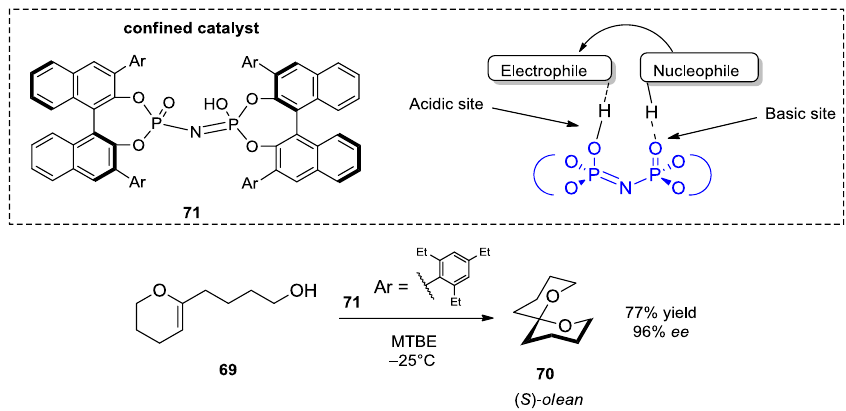
Figure 17. The asymmetric spiroacetalization reaction catalyzed by con fi ned Brønsted acids (BAs); bifunctional con fi ned catalysts ’ pocket, from Ref.